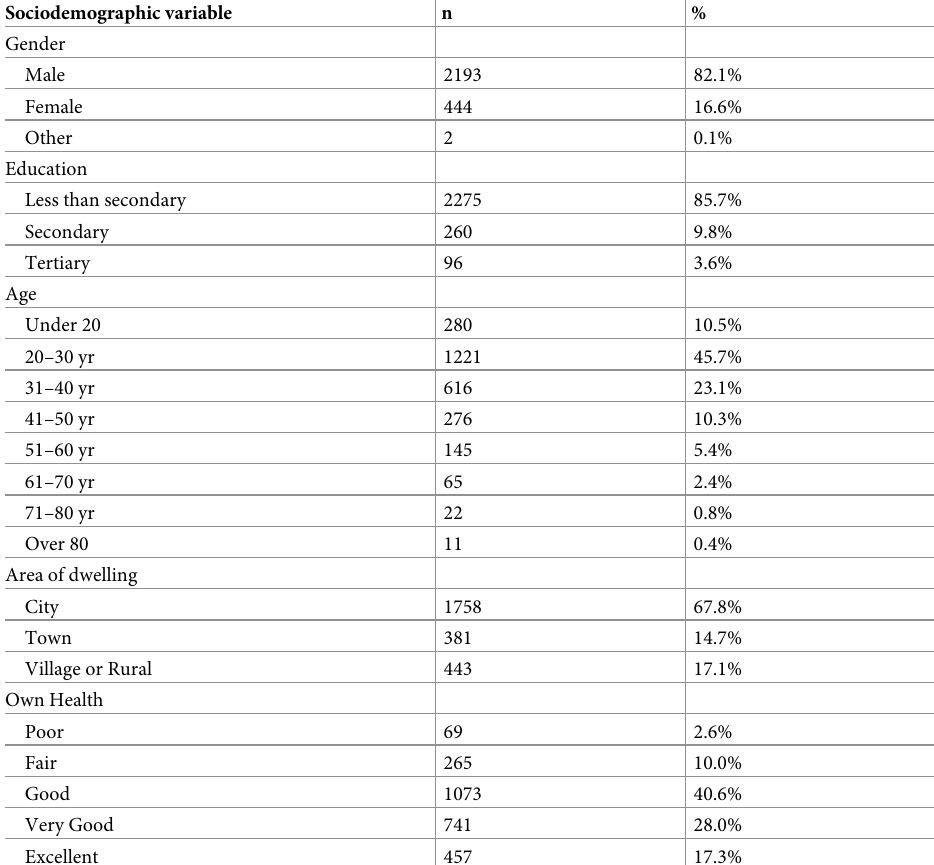
Table 1. Baseline characteristics of the study population (n = 2,671).